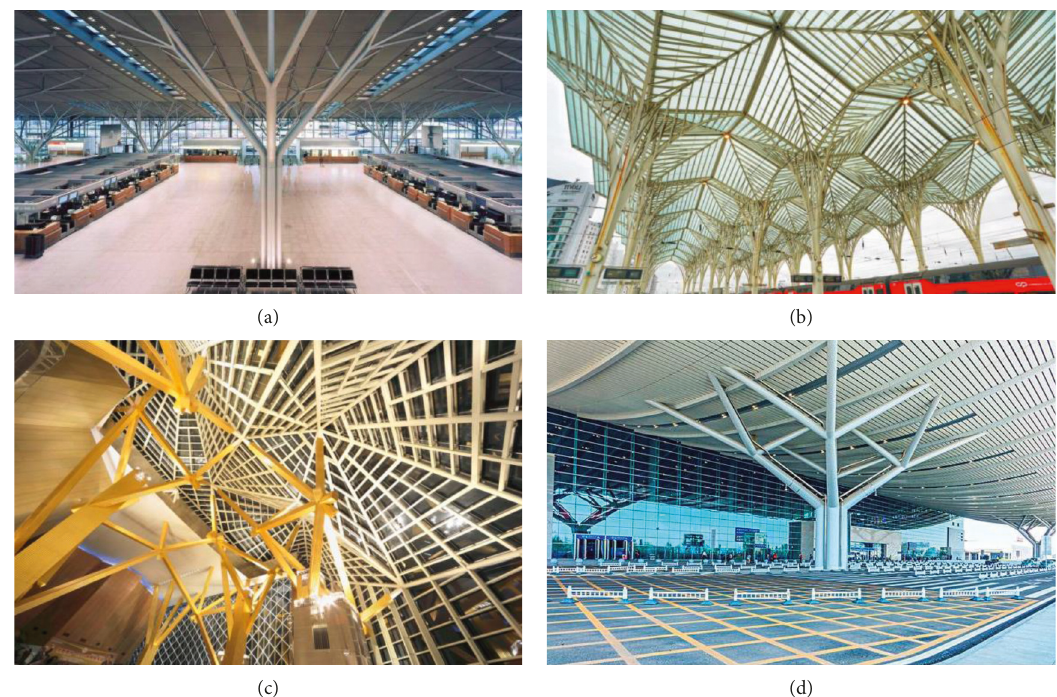
Figure 1: Application of dendritic structure in domestic and foreign projects. (a) Stuttgart airport terminals, Germany. (b) East Station in Lisbon. (c) Shenzhen Cultural Center. (d) Changsha South Railway